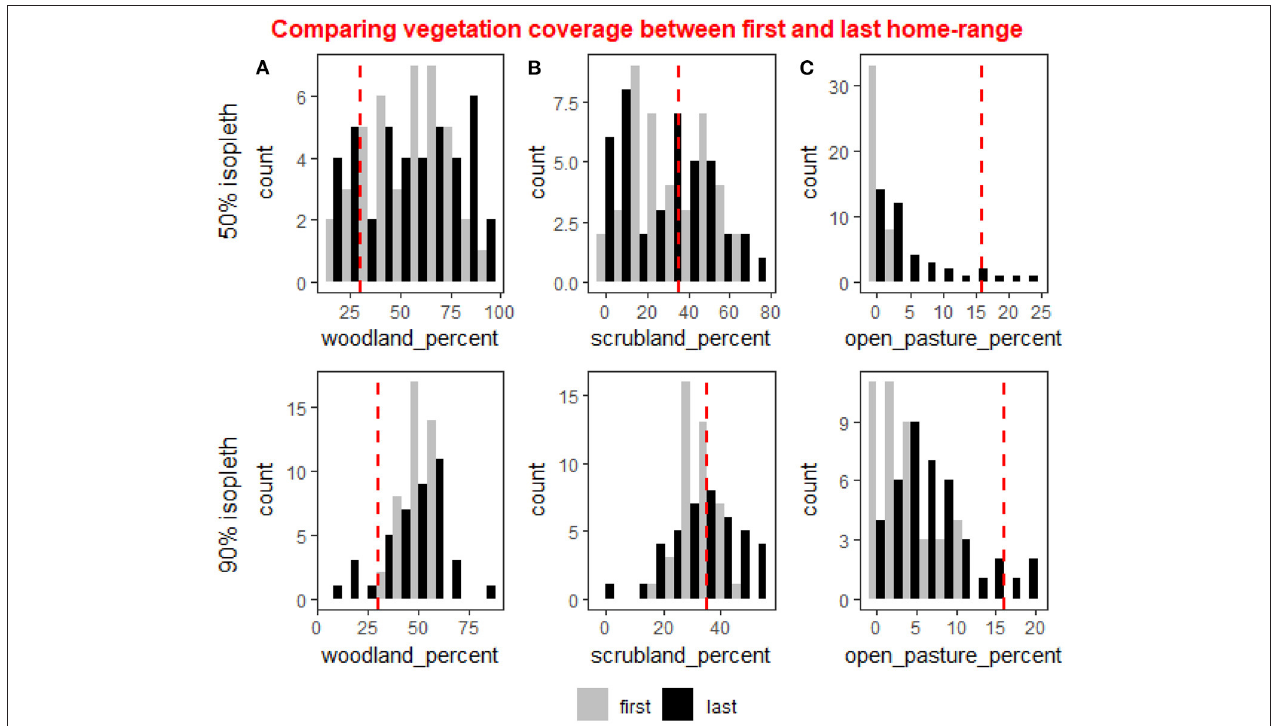
FIGURE 3 | The distribution of the percent coverage in individuals home ranges of three types of vegetation cover: woodland (A) , scrubland (B) , and open pasture (C) shown for the 50% isopleth (core of the home range, upper row) and the 90% isopleth (entire home range, lower row) in the first year after reintroduction (gray bars) and last year of tracking (black bars). In the 90% isopleth average percent woodland was reduced slightly (weighted t -test: p = 0.07) between the first and last year but the distribution was significantly wider during the last year ( χ 2 : p = 0.049). In the 50% isopleth both the average percent woodland and the distribution did not vary between the first and last year. (B) In the 90% isopleth average percent scrubland did not change between the first and last year but the distribution was significantly wider during the first year ( χ 2 : p = 0.005). In the 50% isopleth the average percent scrubland did not change but the distribution varied between the first and last year ( χ 2 : p = 0.04). (C) In the 90% isopleth and in the 50% isopleth the deer avoided open pastures during the first and last year, but in the 90% isopleth the deer increased the amount of open pasture between the first and last year (weighted t -test: p < 0.001) and the distribution was significantly wider ( χ 2 : p = 0.02). In the 50% isopleth both the average percent open pasture and the distribution differed significantly between the first and last year (weighted t -test: p < 0.001, χ 2 : p <